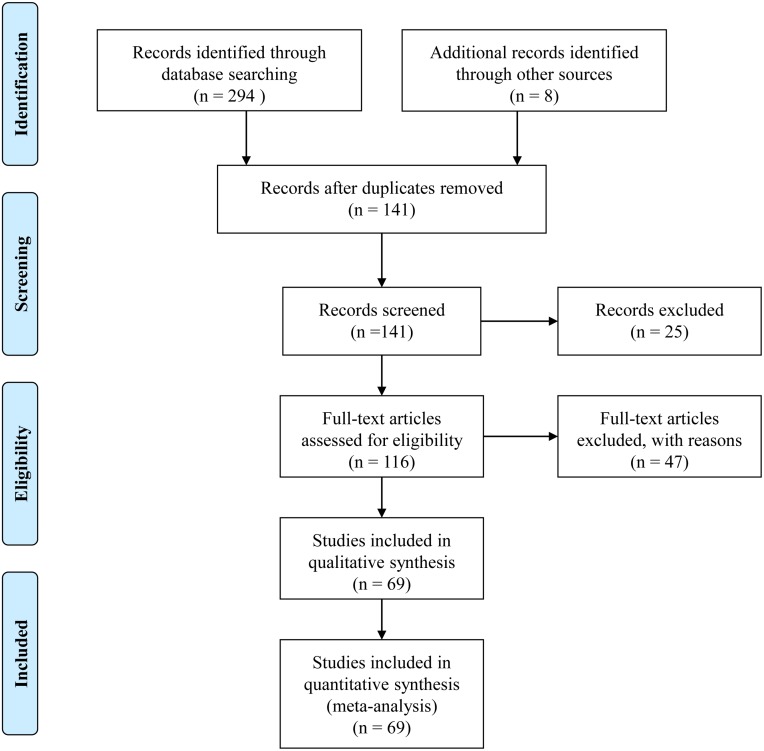
Flow diagram reporting the number of records identified, excluded, and added during the screening process.